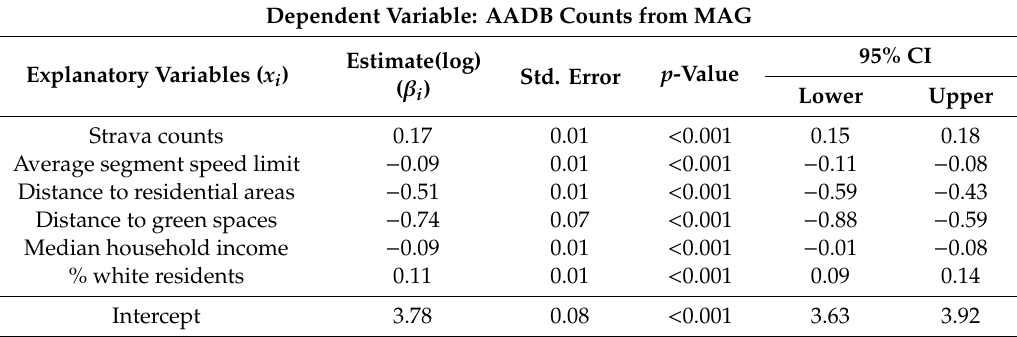
Table 3. Parameter estimates using Poisson